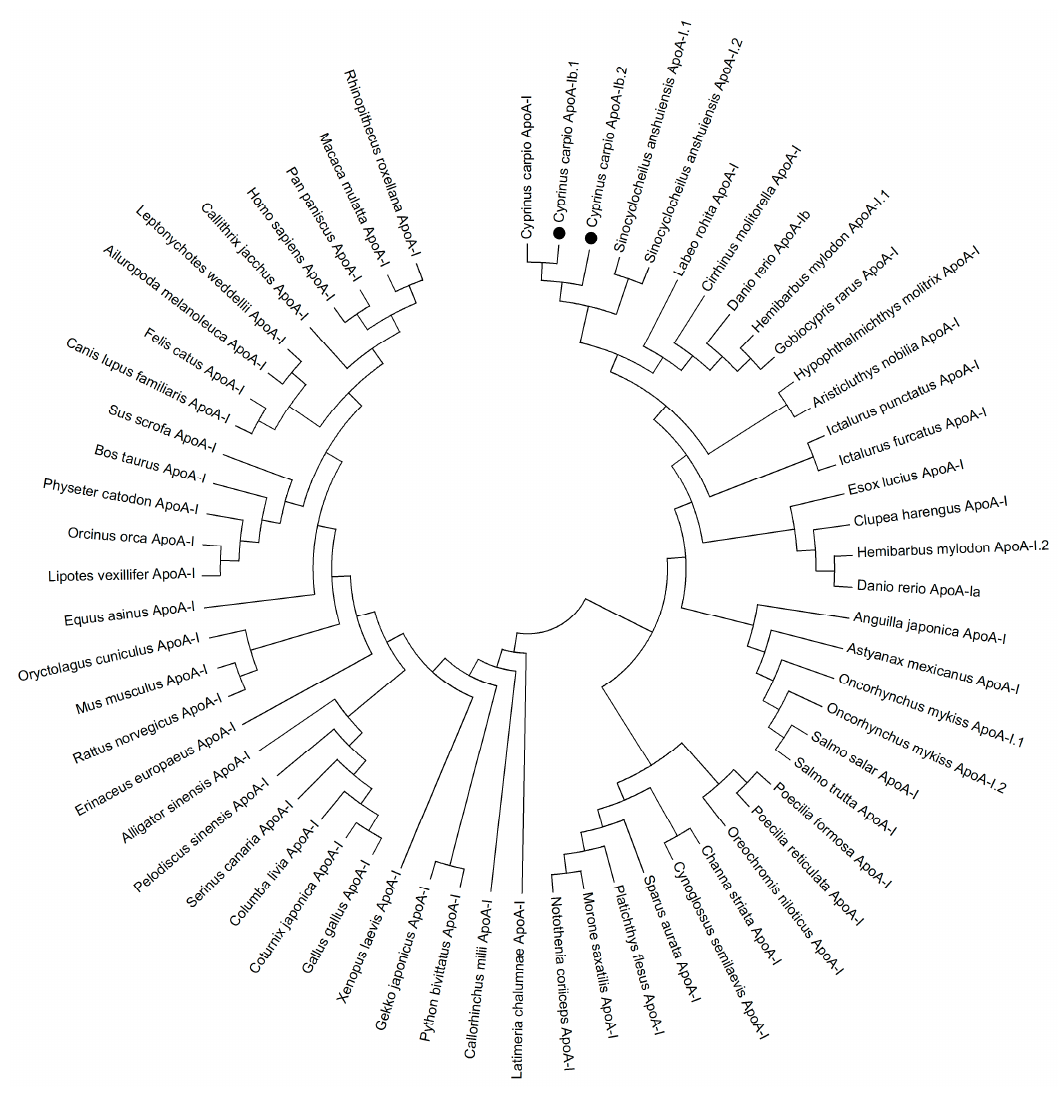
Figure 2. Neighbor-joining phylogenetic tree based on 63 ApoA-I protein sequences of vertebrates. Cyprinus carpio ApoA-Ib.1 and ApoA-Ib.2 were marked by bold dot.